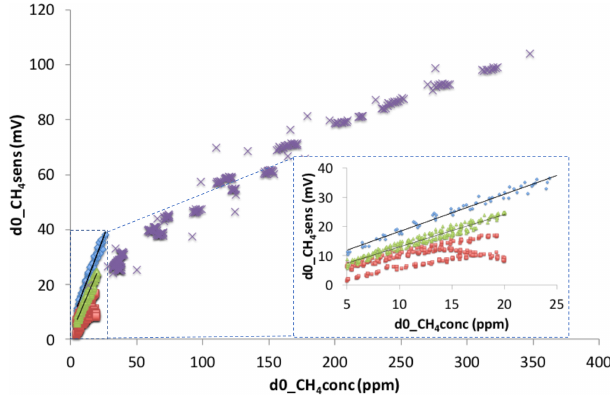
Figure 5. Response curves of the CH 4 sensor’s responses at all ex- perimental water temperatures from 10 to 30 ◦ C versus the change in CH 4 mixing ratio measured by GC-FID or a Los Gatos Re- search FGGA greenhouse gas analyzer (d0_CH 4 conc). The blue diamonds, green triangles, purple crosses ( (cid:49) , x : for a CH 4 concen- tration higher than 25ppm), and red squares represent the change in the CH 4 sensor signal over time from the chamber closure (d0_CH 4 sens) of the TGS2611-E00, NGM2611-E13 and the Pan- terra sensor, respectively. See text for